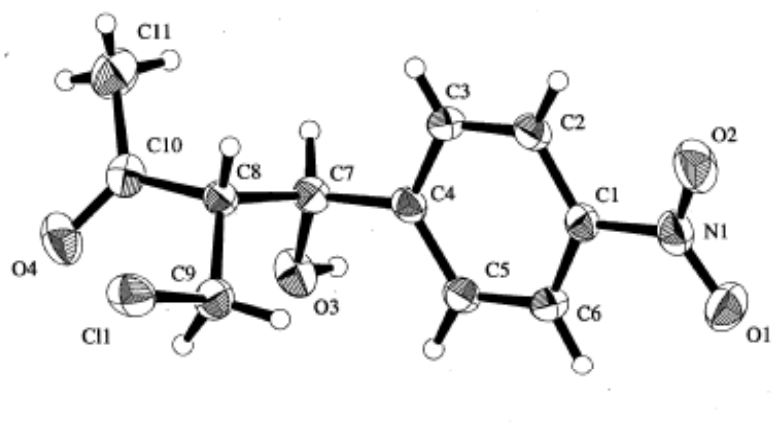
Figure 1: Crystal Structure of